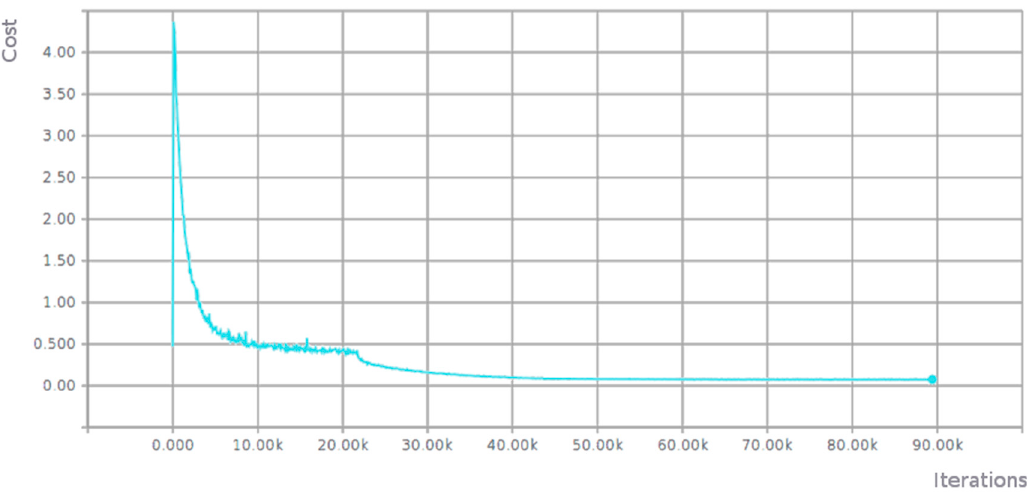
Figure 3. Reduction of associated cost during training of the AlexNet network.